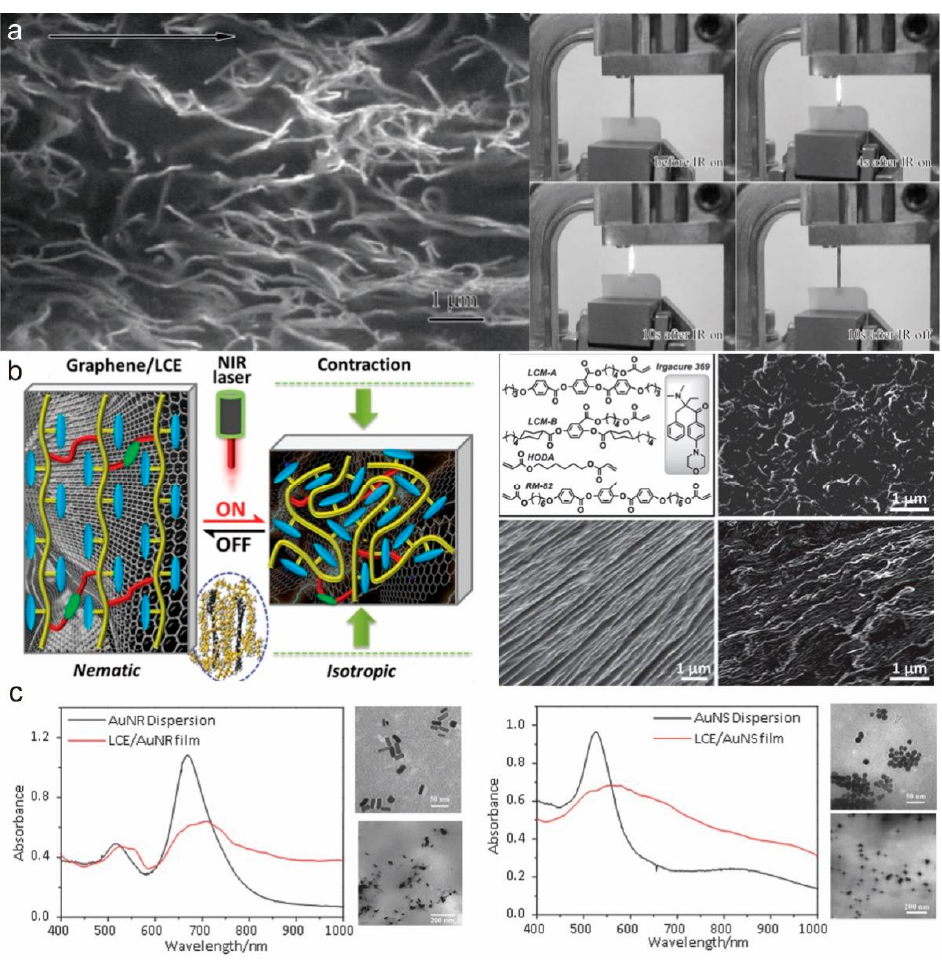
Figure 3. LCE composites. ( a ) CNT/LCE composite material (Reprinted with permission from Ref.